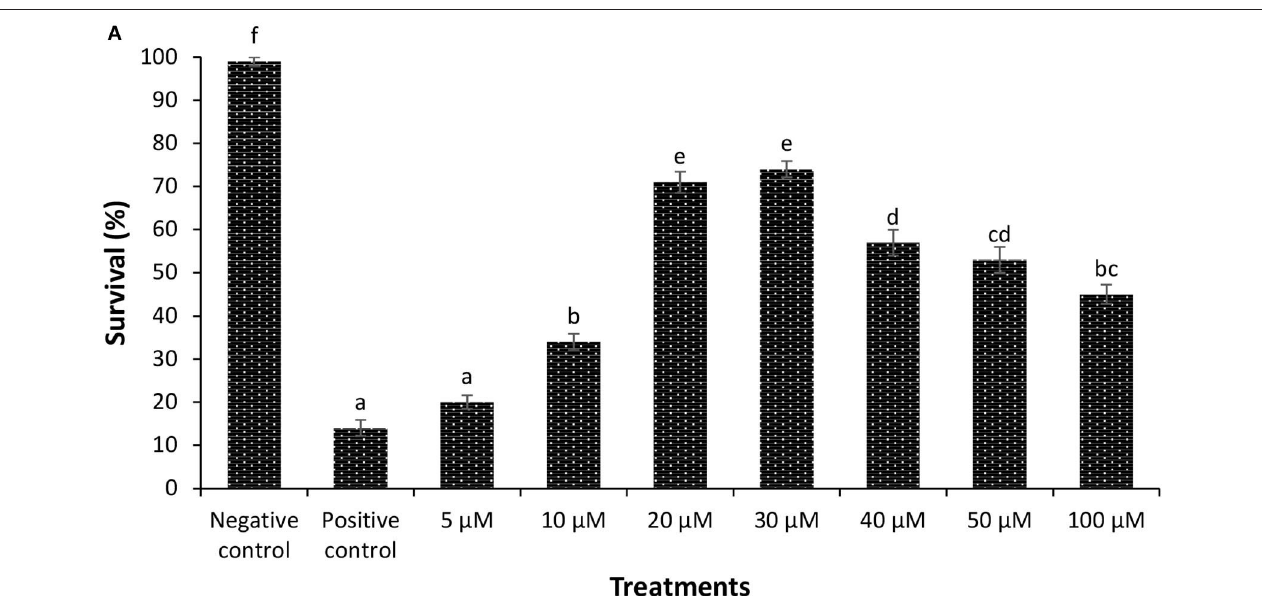
FIGURE 1 | (A) Survival (%) of phloroglucinol-pretreated brine shrimp larvae after 48h of challenge with V. parahaemolyticus MO904. The larvae were pretreated with phloroglucinol at the indicated doses for 2h, rinsed to wash away the compound, and then allowed to recover for 2h. The larvae were subsequently challenged with V. parahaemolyticus at 10 7 cells/ml of rearing water. Non-pretreated larvae that were either challenged with V. parahaemolyticus (positive control) or unchallenged (negative control) served as controls. Error bars represent the standard error of five replicates; different letters indicate significant differences ( P <